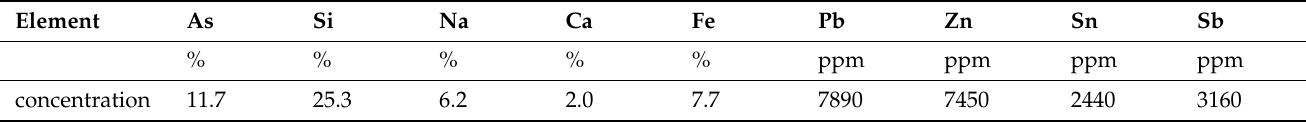
Table 2. The major composition of digested liquor of glass material